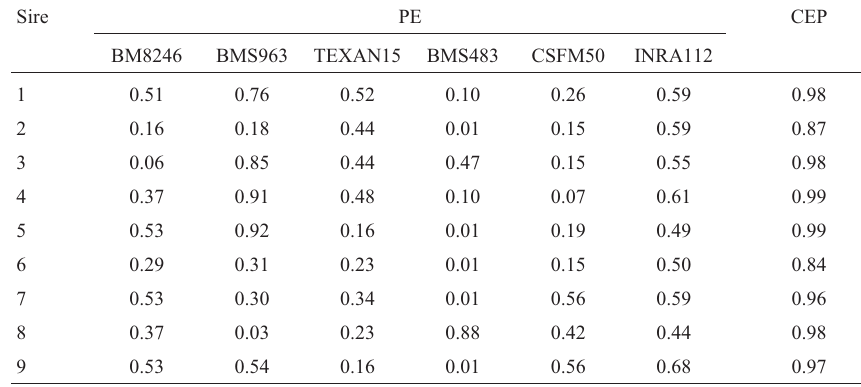
Table III - Exclusion probability (EP) and combined exclusion probability (CEP) for nine bulls and six microsatellite